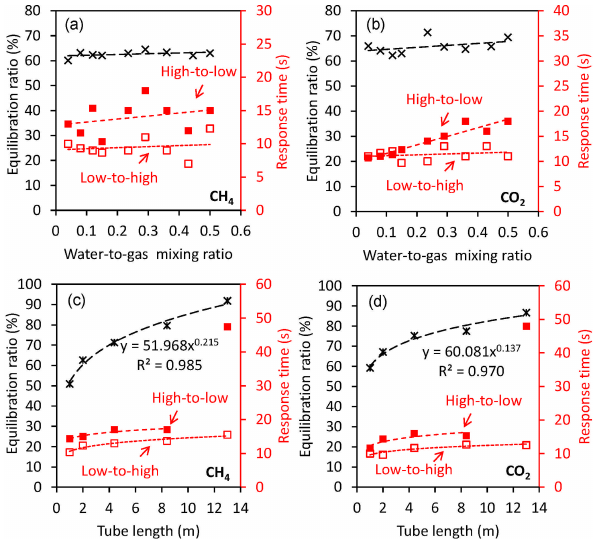
Figure 3. Factors affecting the performance of the gas equilibrator for both dissolved CH 4 and CO 2 . (a, b) Equilibration ratio and re- sponse time in response to changing water–gas mixing ratio (with a 2m tube in the gas–water mixing unit). Black cross symbols are equilibration ratios, and low-to-high and high-to-low response times are represented by red open and solid squares, respectively. (c, d) Equilibration ratio and response time in response to changing tube length of the gas–water mixing unit (with a fixed water-to-gas mixing ratio of 0.5). Black cross symbols are equilibration ratios, and low-to-high and high-to-low response times are represented by red open and solid squares, respectively.